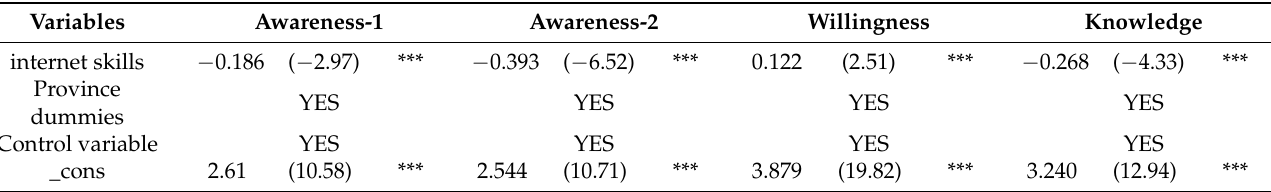
Table A1. OLS estimation results of 4 basic